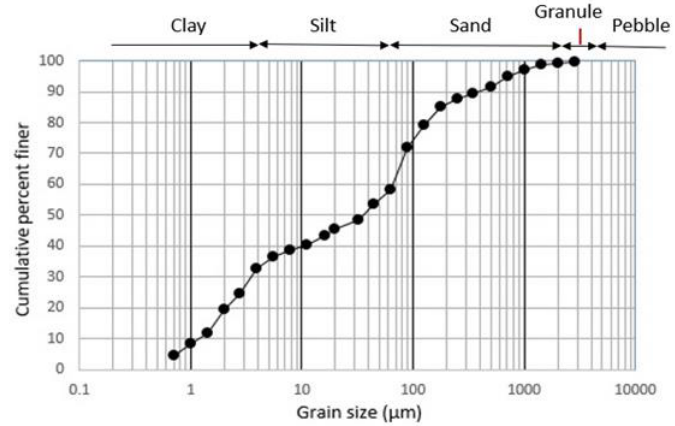
Figure 8. Grain size distribution for the bottom sediment at site MD.